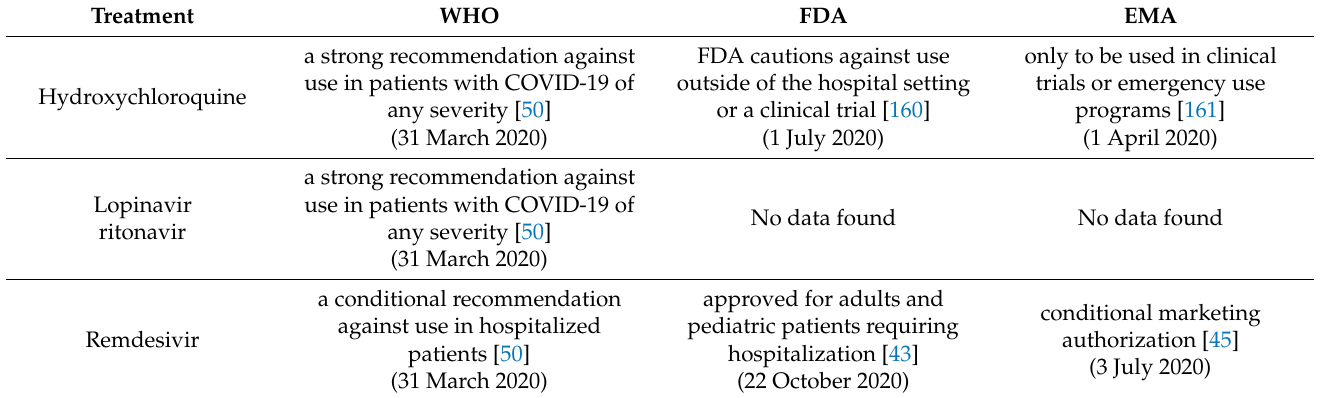
Table 3. Official status of some potential treatments for patients with